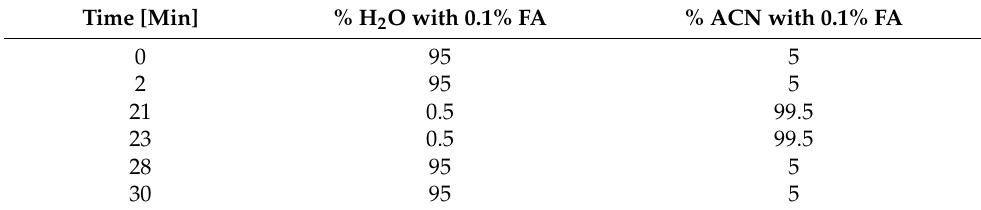
Table 1. Gradient used for LC-MS/MS